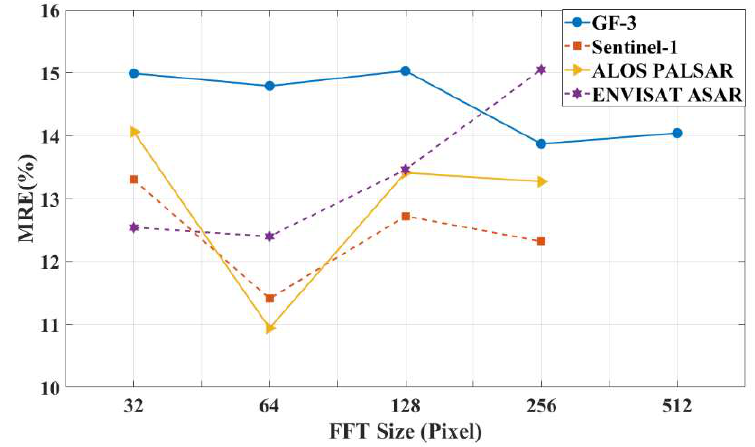
Figure 11. Line chart of bathymetry error of different FFT sizes.